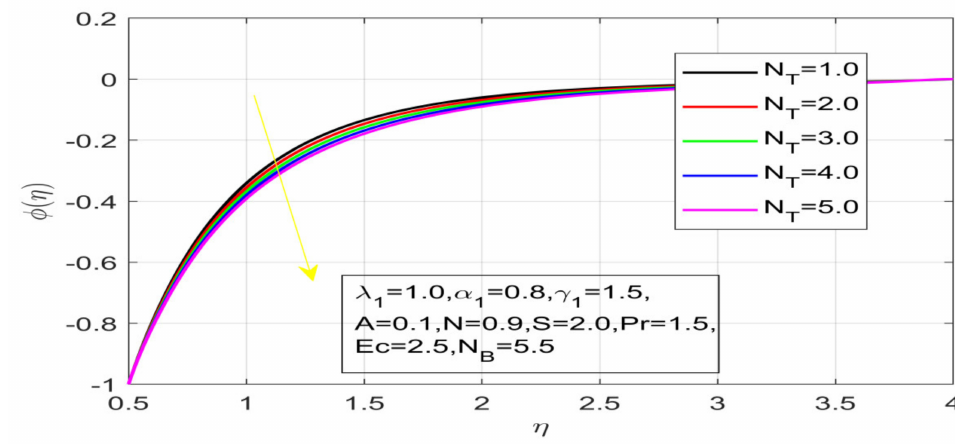
Figure 18. Impact of N_B on concentration.